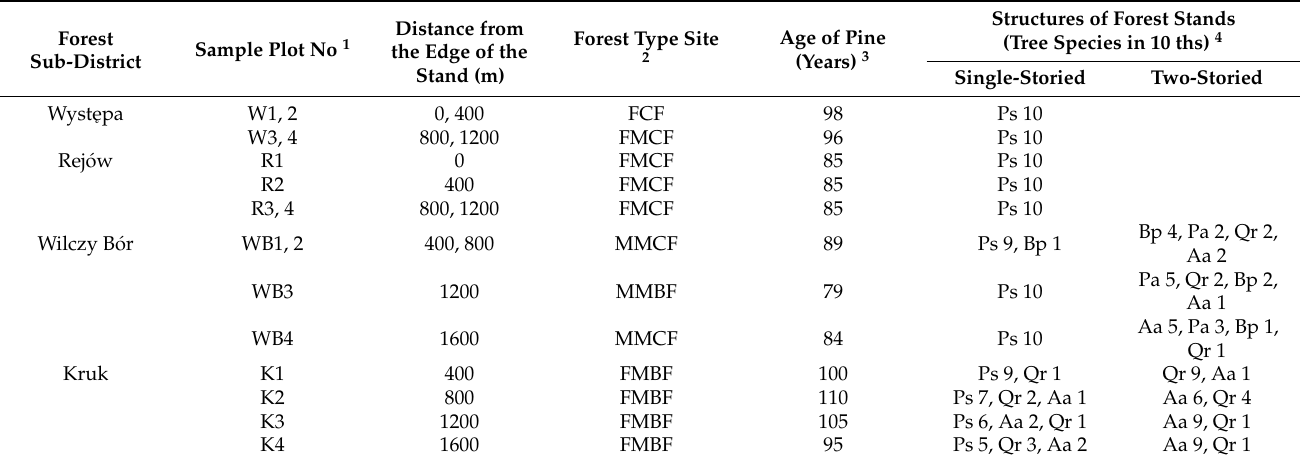
Table 1. Locality and stand